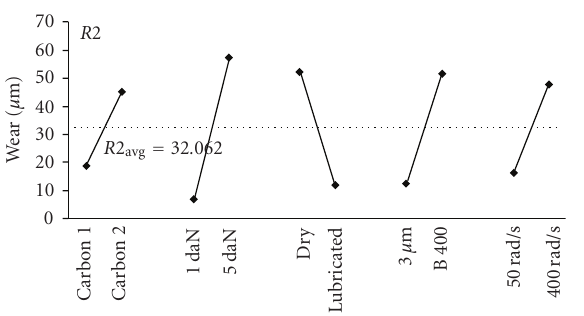
Figure 7: Interaction e ff ects on the wear ( R